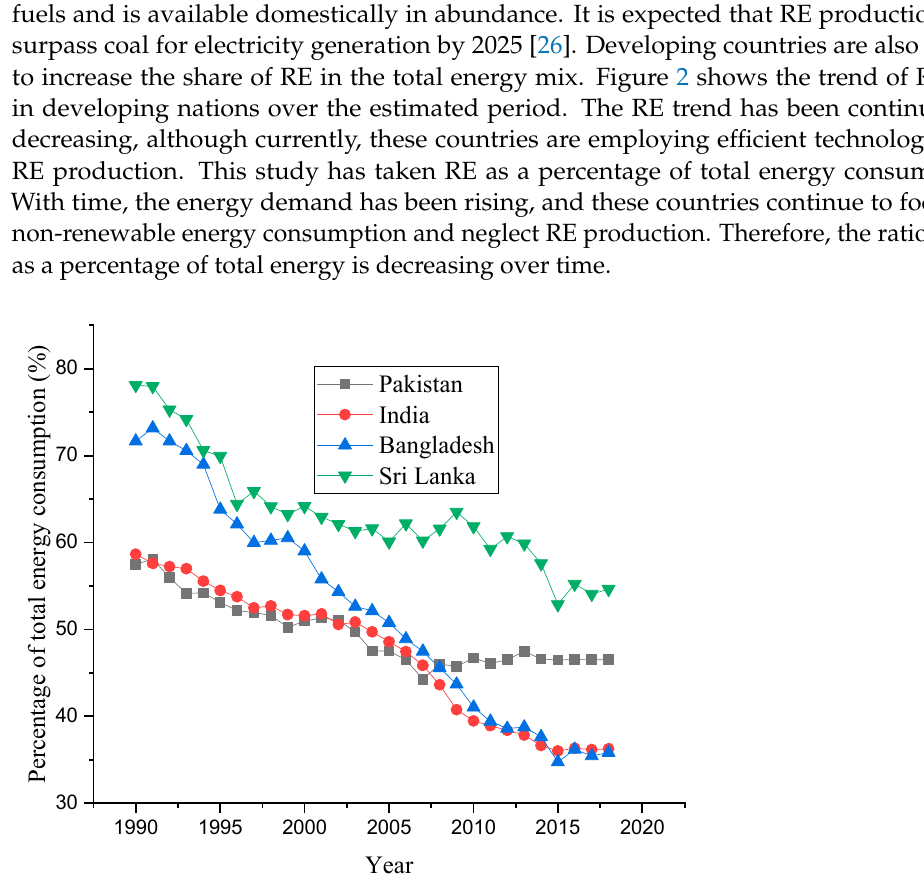
Figure 2. Trends of renewable energy use in South Asian nations (Source: World Bank) .